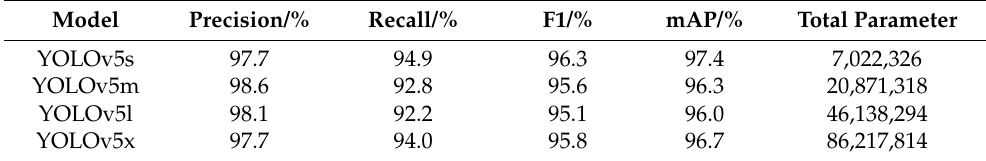
Table 4. Comparison between different YOLOv5 models.